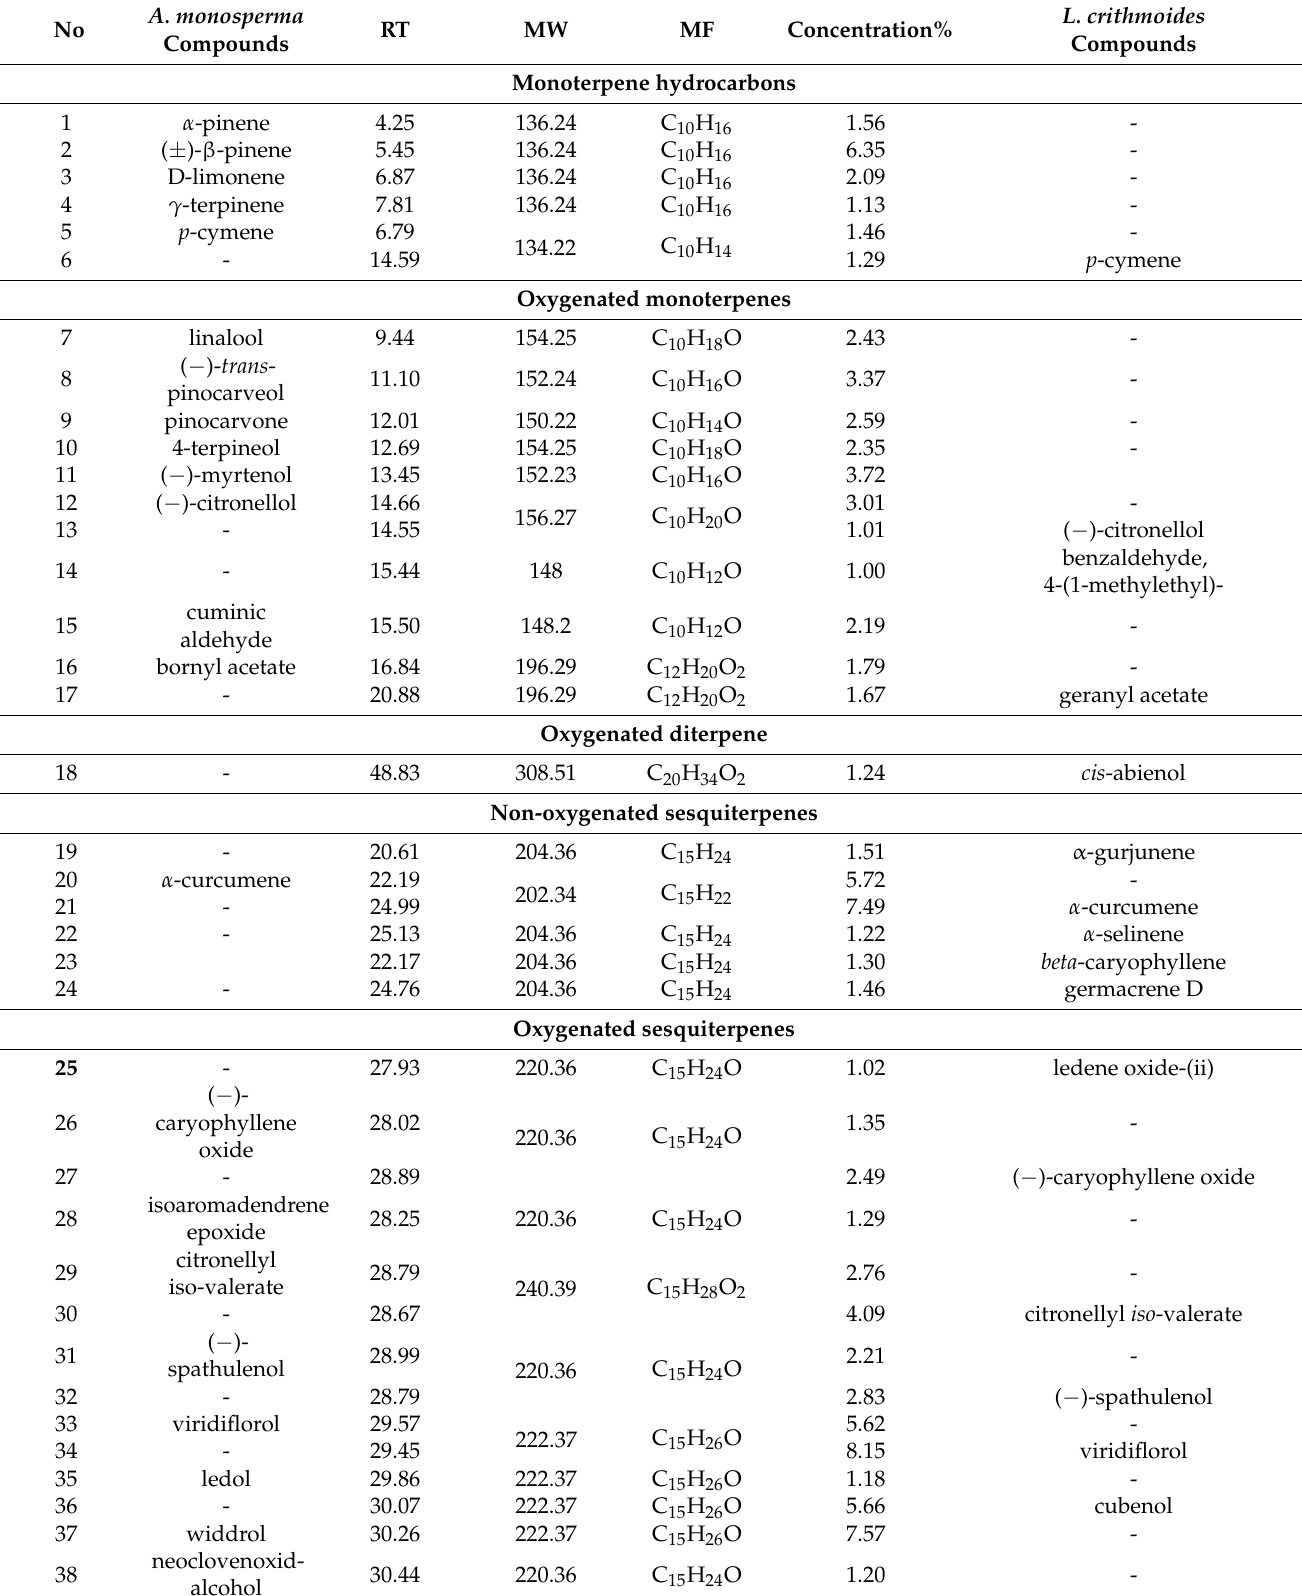
Table 2. Chemical composition of the essential oil (%) from A. monosperma and L. crithmoides